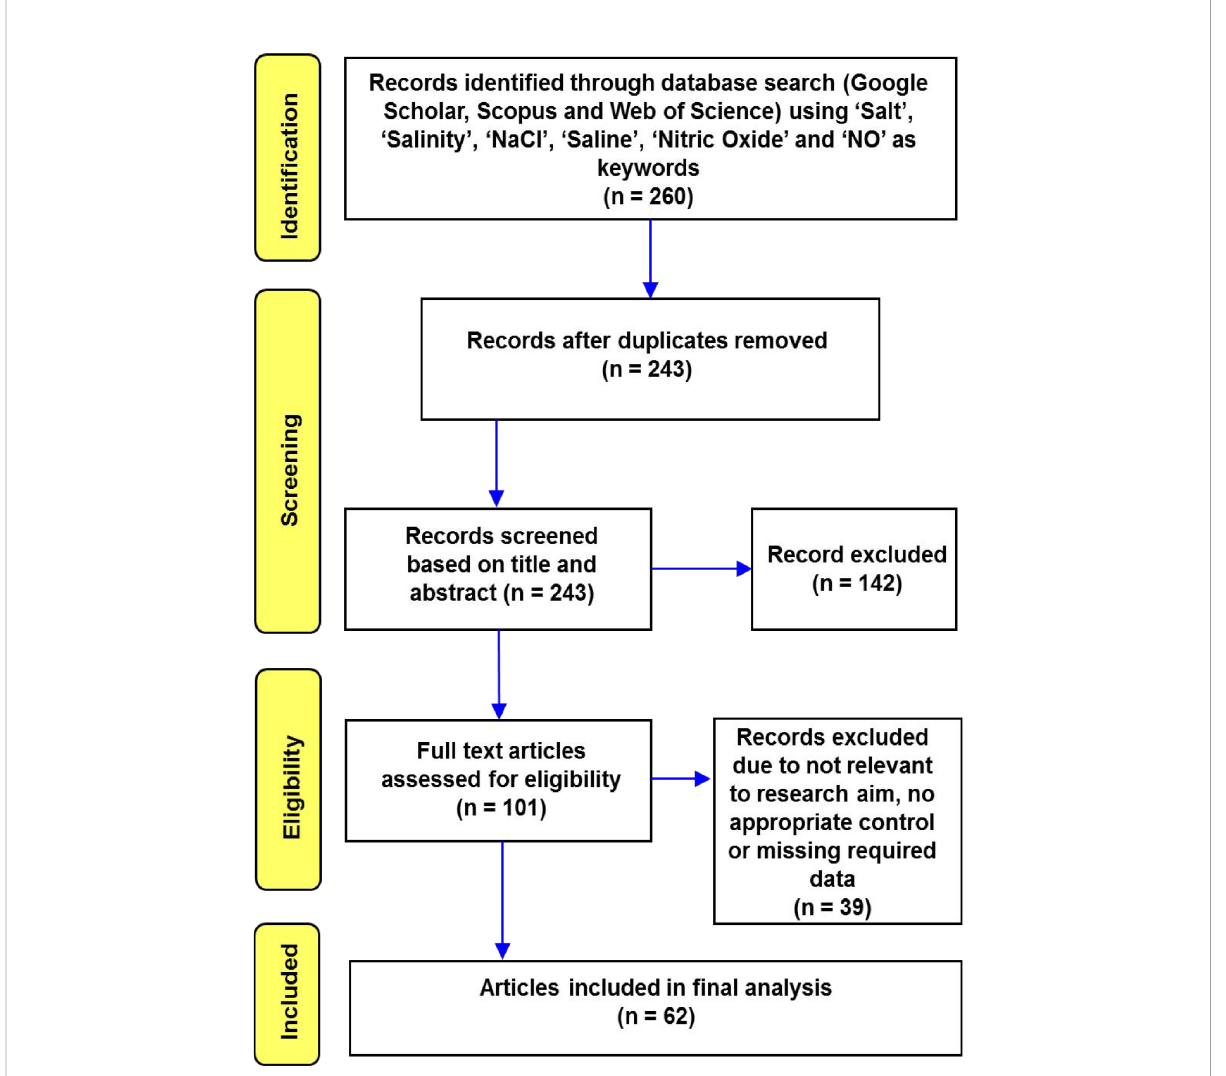
FIGURE 1 Flow chart depicting the Preferred Reporting Items for Systematic Reviews and Meta-Analysis (PRISMA) search strategy used to fi nd and choose published literature for this